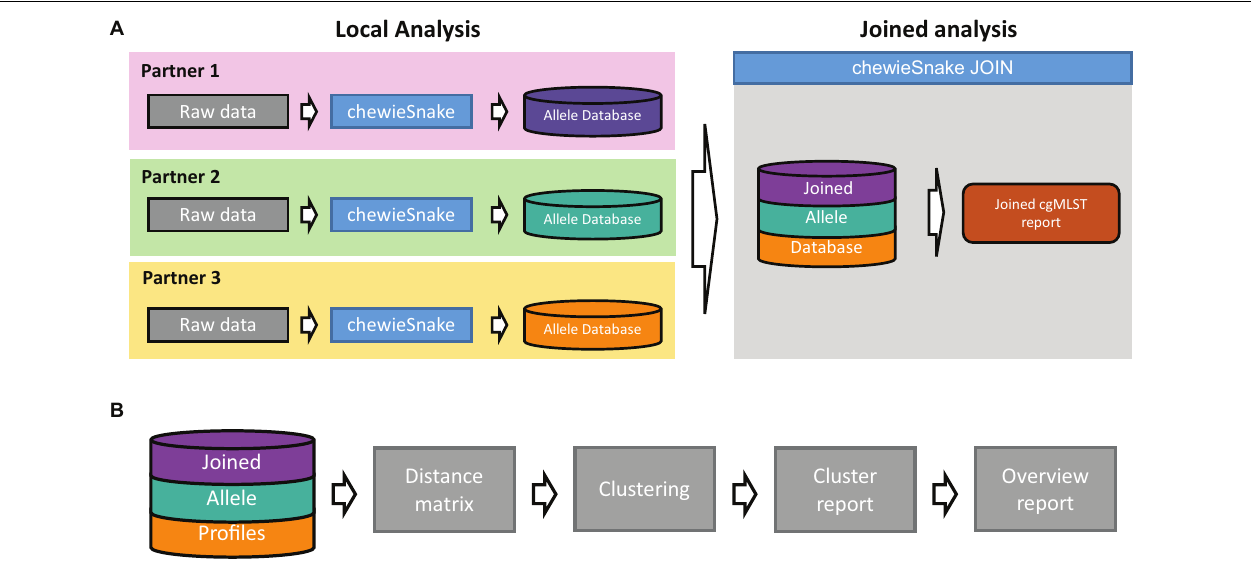
FIGURE 2 | Schematic representation of the c hewieSnake_join workflow. (A) A set of laboratories locally employ the chewieSnake workflow to process incoming raw sequencing data. The resulting allele profiles are stored in individual allele databases, which are subsequently joined with the chewieSnake_join workflow. In addition, the chewieSnake_join workflow computes a joined cgMLST report. (B) Detailed description of the chewieSnake_join workflow. From the joined allele profiles, the allele distance matrix is computed, followed by cluster typing of the entire dataset. Detailed reports for each cluster as well as an overall report summarize the results in an interactive HTML